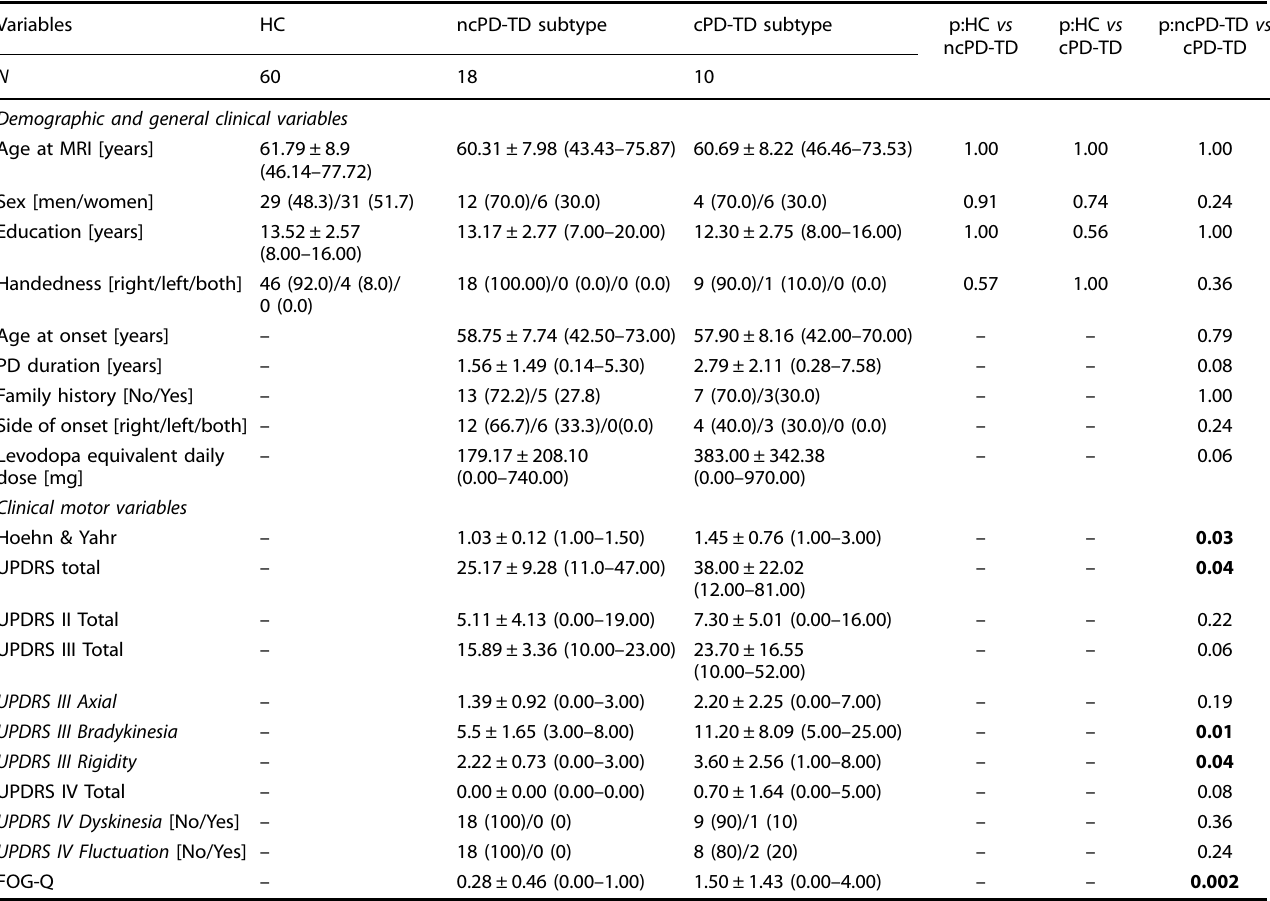
Table 2. Demographic and clinical characteristics of healthy controls, cPD-TD and ncPD-TD